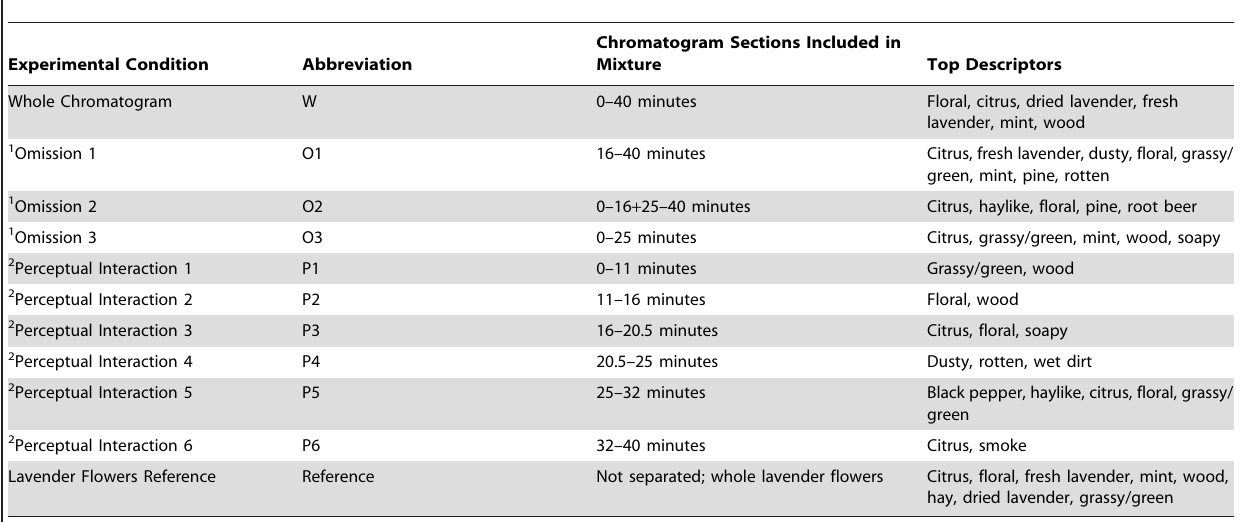
Table 1. Experimental GC-O conditions and aroma descriptors for mixtures of volatiles from the lavender